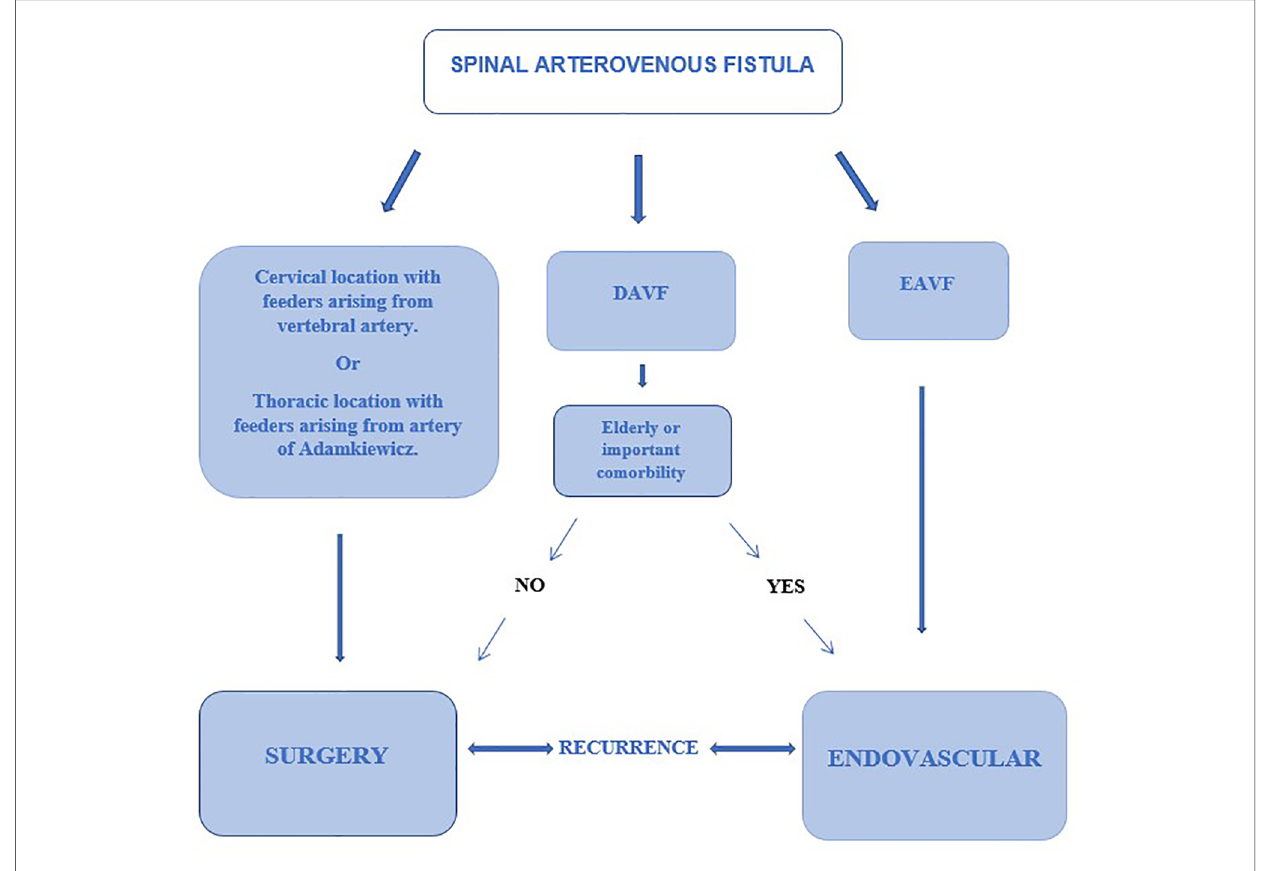
FIGURE 4 Decision making algorithm for treatment of spinal arteriovenous fi